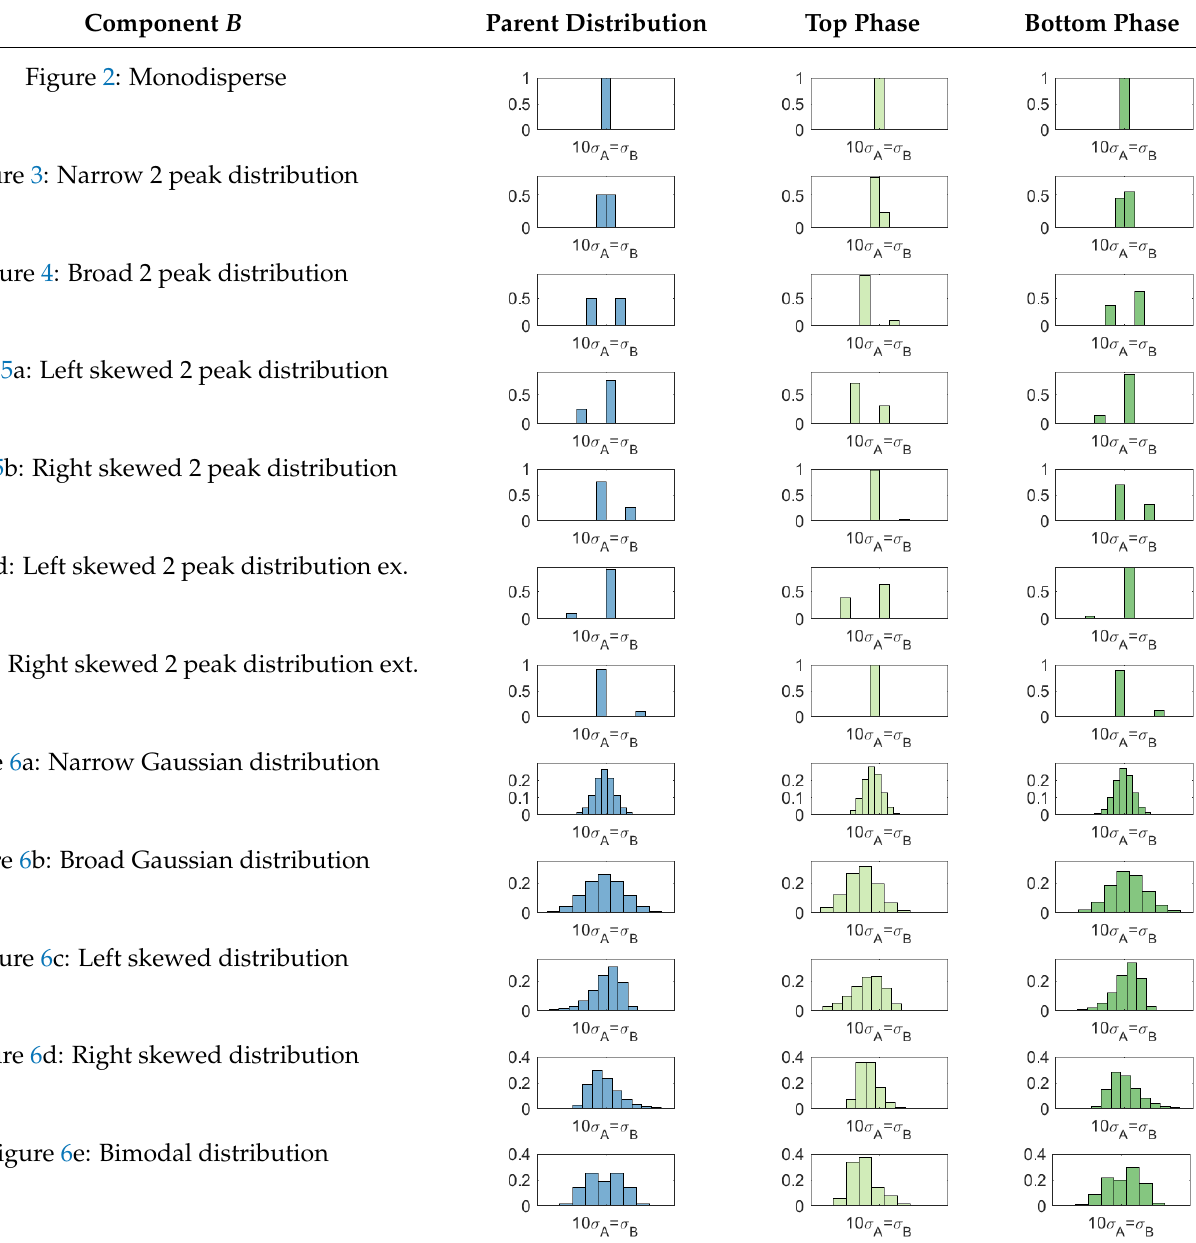
Table 2. Phase separation of different mixtures and fractionation of component B for specific parent distribution ( η A = 0.200), depending on distribution of component B , see also Figures 2–6. 0.010, η B parent Component B Parent Distribution Top Phase Bottom Phase Figure 2: Monodisperse